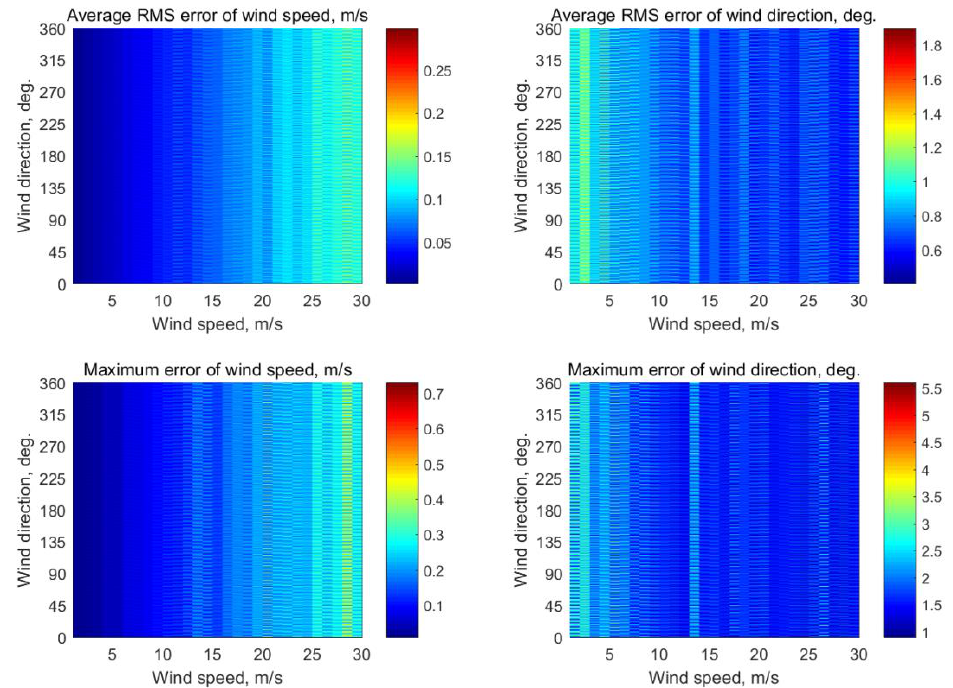
Figure A12. Simulation results of the use of two incidence angles of 50° and 55° for wind retrieval.